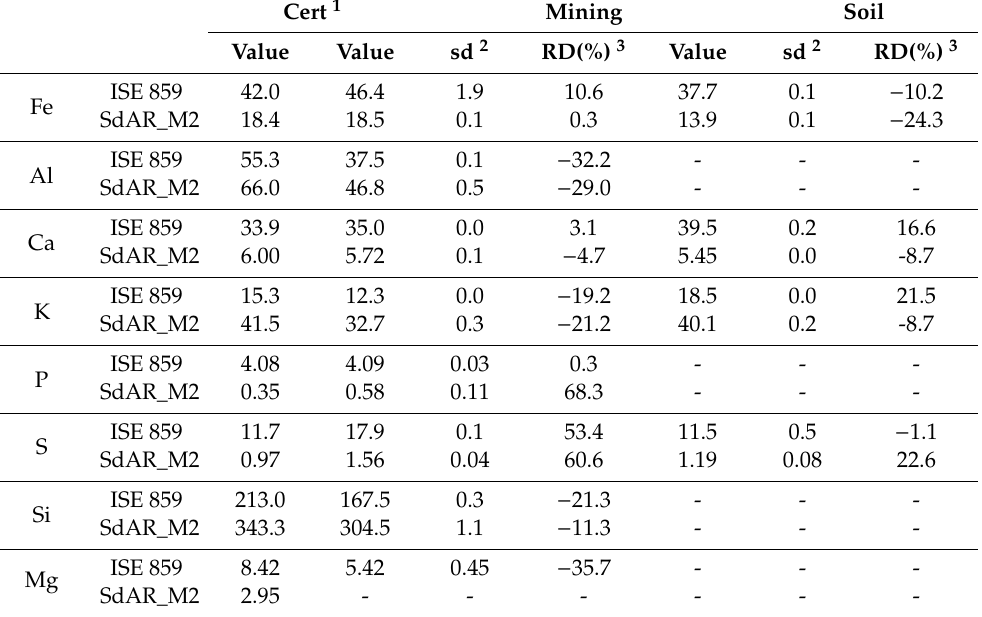
Table 3. Real total contents (g kg − 1 ) of the sediment samples ISE 859 and SdAR-M2 as determined using the Mining and Soil methods of the portable X-ray spectrometer